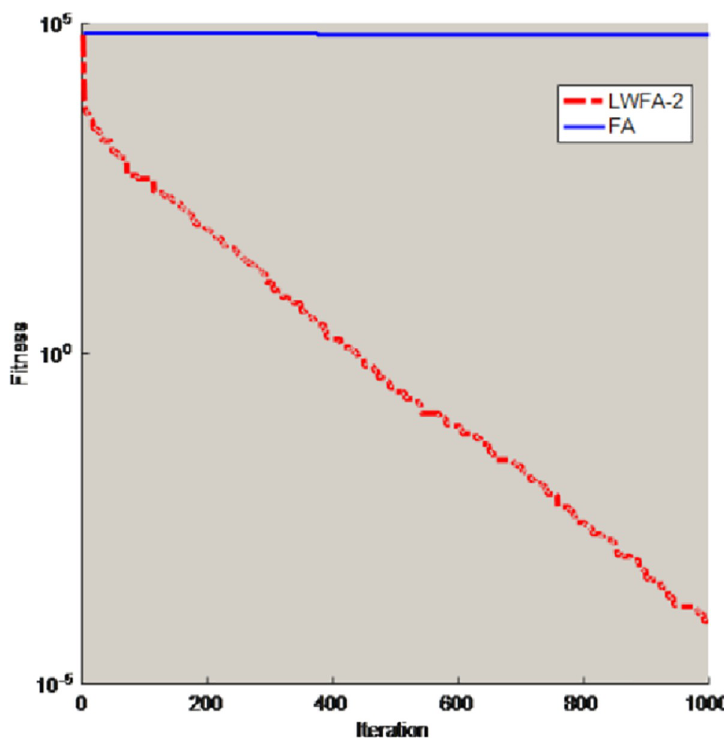
Fig 5. Convergence curves of unimodal functions f 2 .